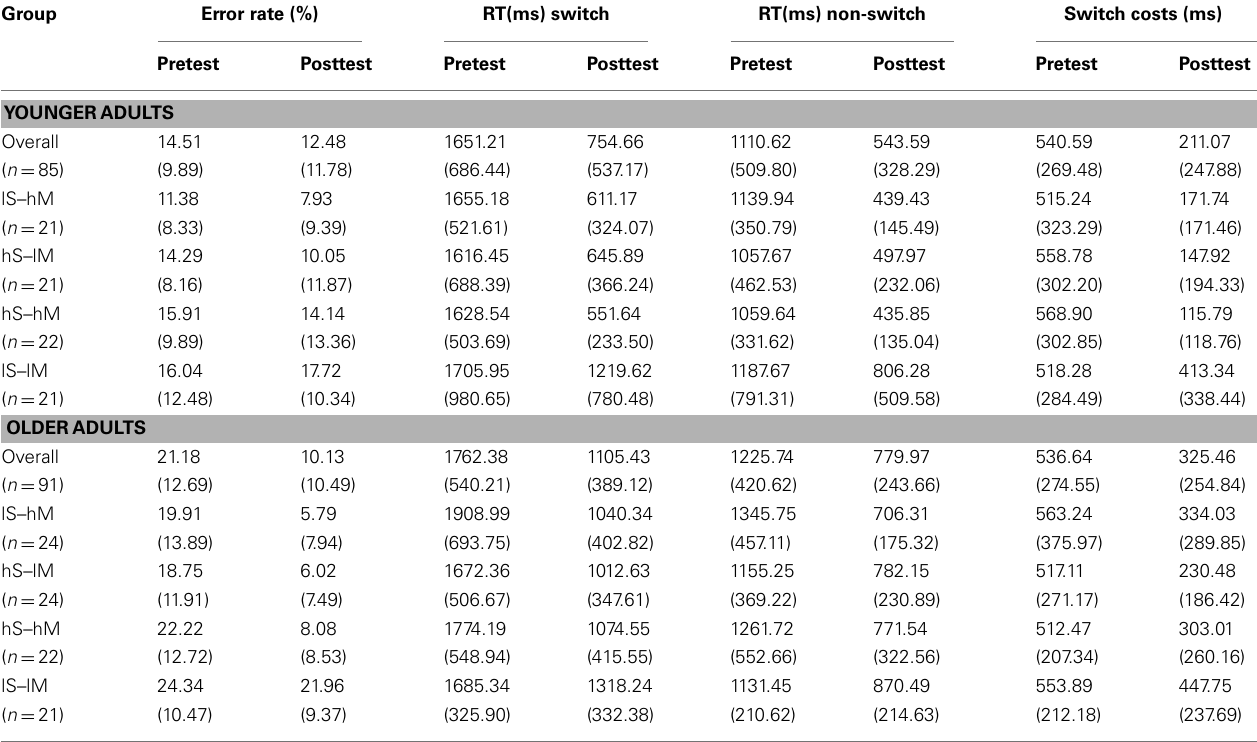
Table 2 | Mean performance and SD for error rate, reaction time for switches (RT switch) and non-switches (RT non-switch), and switch costs as a function of age group, training group, and session (pretest,